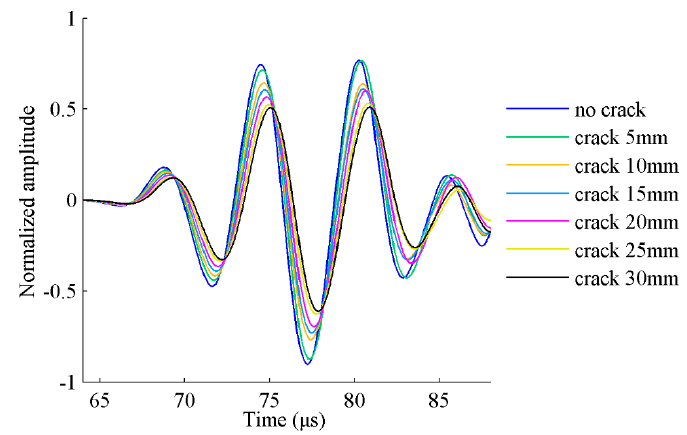
Figure 5. Lamb wave response data for healthy and damaged plates in the desired time window.